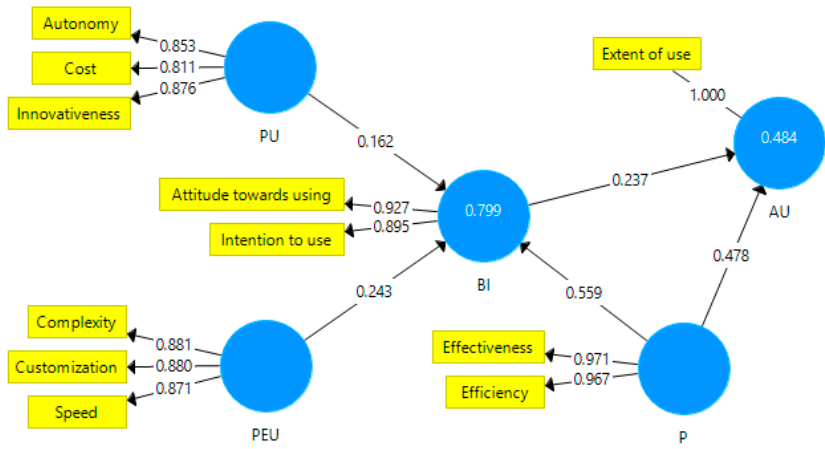
Figure 4. Empirical model. Source: author’s design using SmartPLS v3.0.